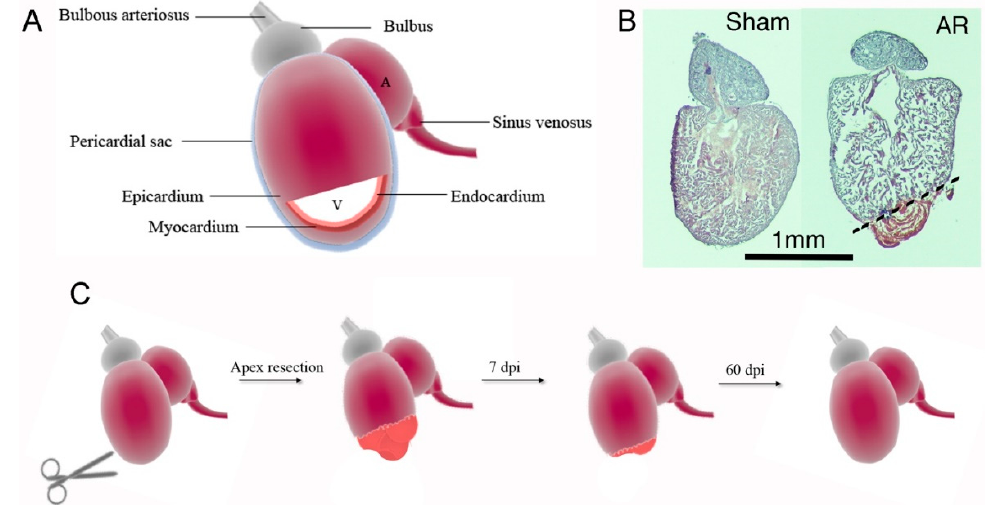
Figure 1. Apex resected (AR) zebrafish hearts regenerates during a 60 days time course. ( A ) The zebrafish heart consists of an atrium (A) and a ventricle (V). The cardiac layers, starting from the inner, is called endocardium, myocardium and epicardium. The heart is furthermore covered by a pericardial sac. The blood comes from the sinus venosus into the atrium and goes to the ventricle and out through bulbous arteriosus. ( B ) Hematoxylin staining of zebrafish hearts following sham surgery and AR of 10–20% of the heart. ( C ) Schematic representation of the overall processes occurring following AR in the zebrafish heart. Initially, a fibrin clot is formed in the apex region, whereafter cardiomyocytes starts to proliferate, peaking at 7–14 dpi, and regenerates the heart until 60 dpi, when it is fully recovered.